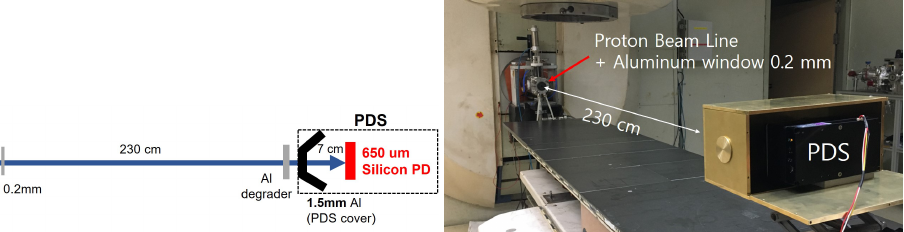
Figure 10. Schematic Diagram and Picture of an Experimental Setup for the Proton-beam Energy Measurement in the MC50 Cyclotron at the Korea Institute of Radiological and Medical Sciences in Seoul.